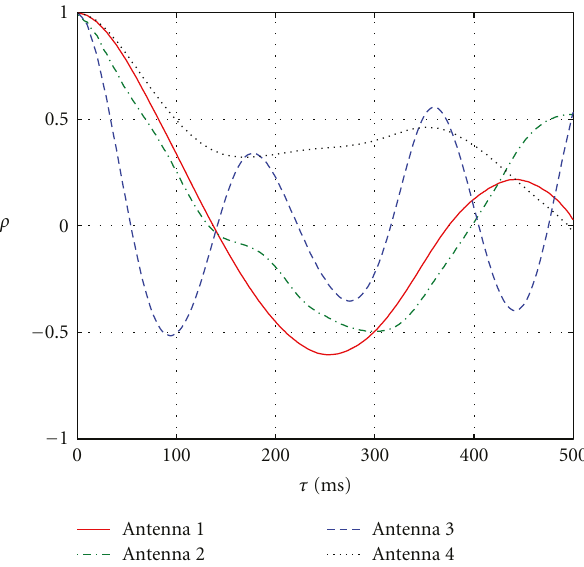
Figure 7: Normalized amplitude autocovariance of signals received at 45m distance (path 1, NLoS, 0 . 5 m/s). Colors and antenna numbers are as in the previous figure.